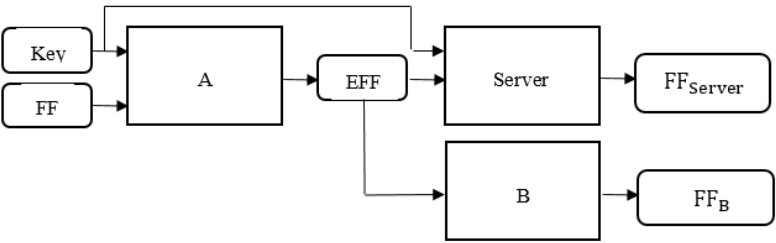
Figure 3. A, Server, and B password system. The A network acts as a Generator here, and the B and Server networks act as Discriminators. Facial features use the key and A network to obtain the encrypted face features, and B and Server are used to restore the encrypted face features to face features.